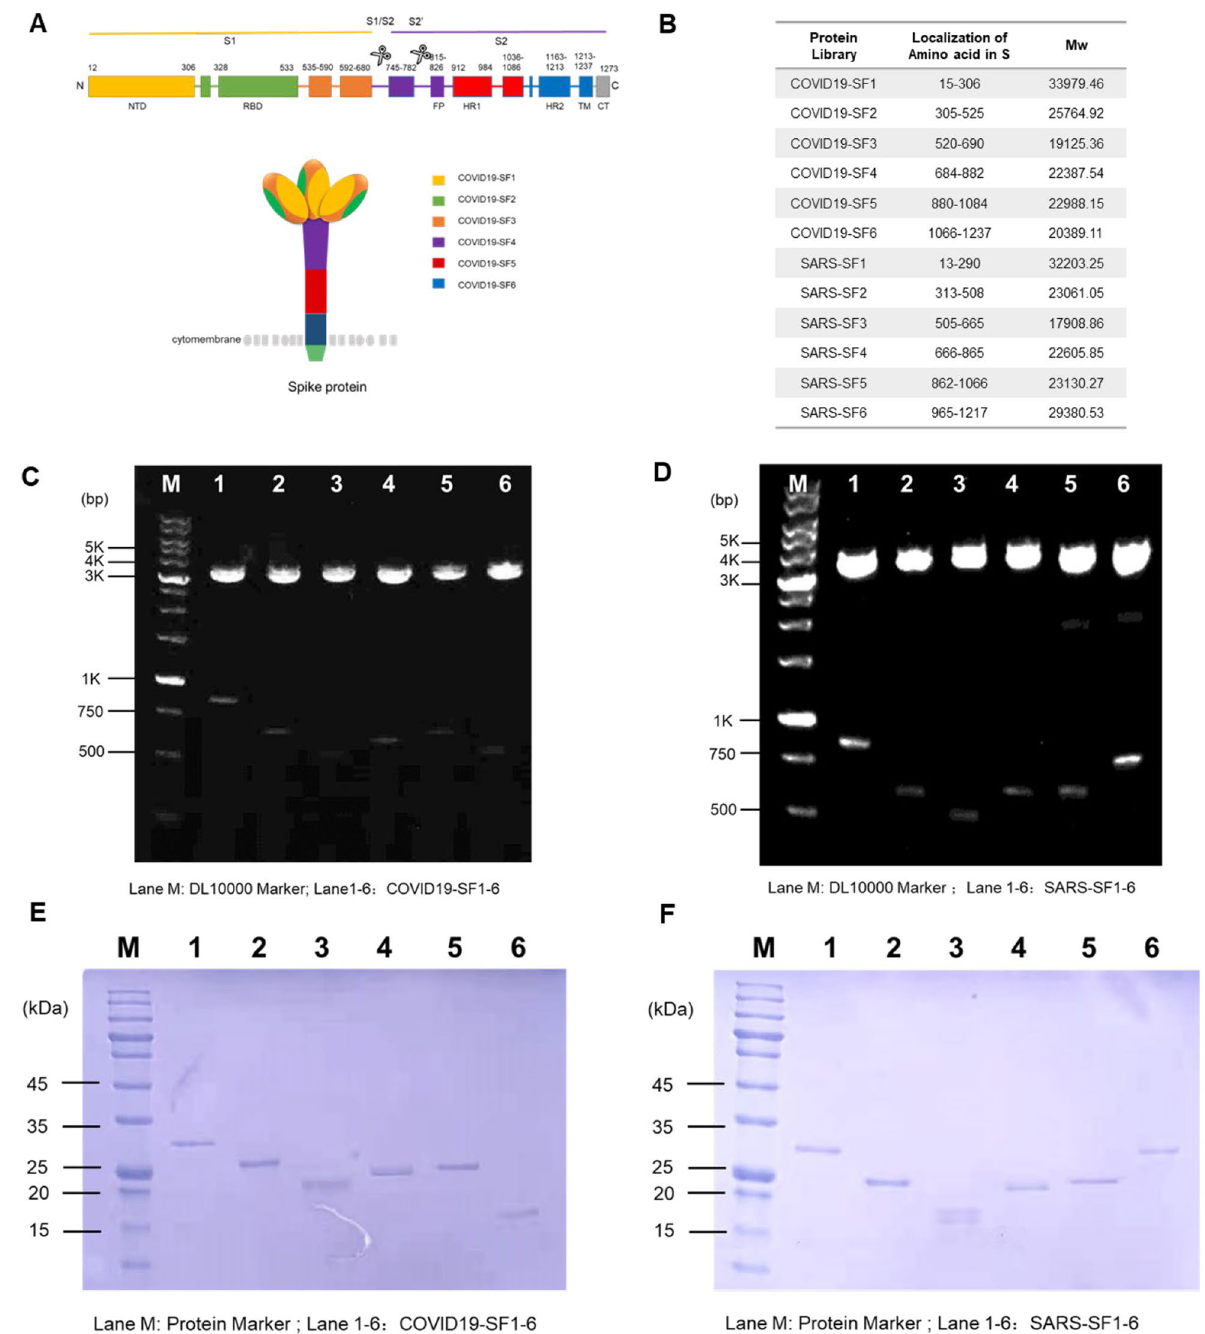
Figure 1. Expression and purification of recombinant spike subunit fragments of SARS-CoV-2 and SARS-CoV. ( A ) Structure features of the SARS-CoV-2 spike (S) protein and the flow chart of protein library construction were generated by Microsoft PowerPoint 2016. The listed domain boundaries are mostly defined according to NTD, N Terminal Domain; RBD, Receptor Binding Domain; FP, Fusion Peptide; HR1, Heptad Repeat 1; HR2, Heptad Repeat 2; TM, Transmembrane Domain; CT, Cytoplasmic Tail. (For visual clarity, the length of the boxes is not proportional to the real sequence length). ( B ) Amino acid location and molecular weight of the protein fragments. ( C and D ) Twelve protein fragments expressing plasmids of SARS-CoV-2 and SARS-CoV were constructed and verified by agarose gel electrophoresis with restriction enzymes BamH I and Hind III. M: DNA markers of known size. Lane1-6: COVID19-SF1-6 ( C ) and SARS-SF1-6 ( D ). ( E and F ) SDS-PAGE analysis of the protein fragments expression of SARS-CoV-2 and SARS-CoV, respectively. M: Prestained protein markers of known size. Lane1-6: COVID19-SF1-6 ( E ) and SARS-SF1-6 ( F